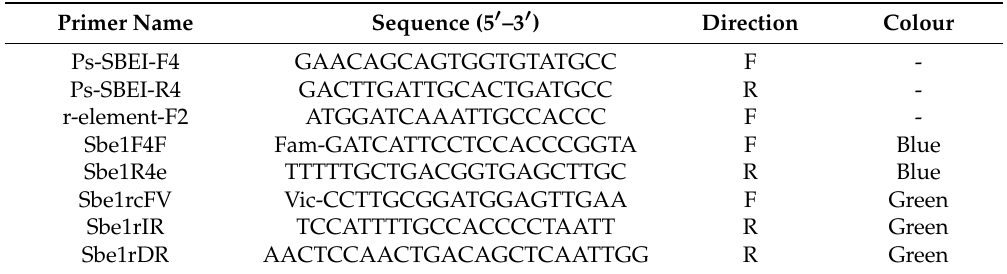
Table 4. Primers used in screening for sbeI variants in pea germplasm. The direction of the primer read is indicated: F, forward; R,